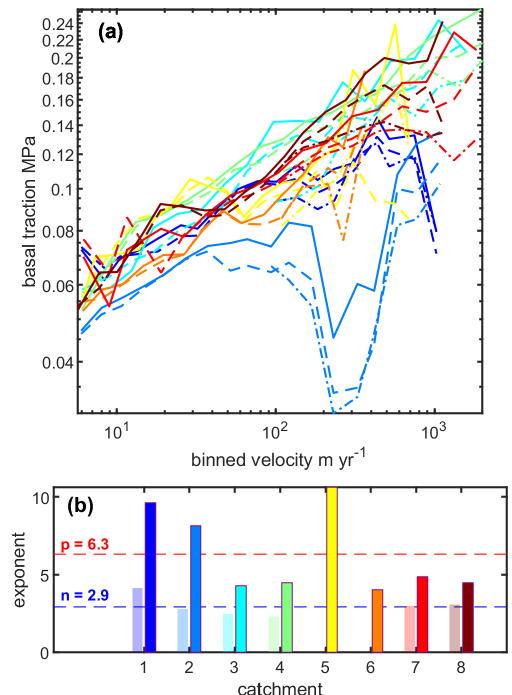
Figure 6. (a) Binned velocity versus traction for all catchments and traction estimates (SIA – solid, SSA – dashed, FS – dash-dotted). (b) The p for likely thawed regions (dark bars) and n for likely frozen regions (light bars) in each catchment. Values for each catch- ment are the average from the SIA and SSA. Dashed lines show the mean value for each exponent. No n is shown for catchments 5 and 6 which did not have enough grid cells to produce a reliable rela- tionship (Fig. S5).